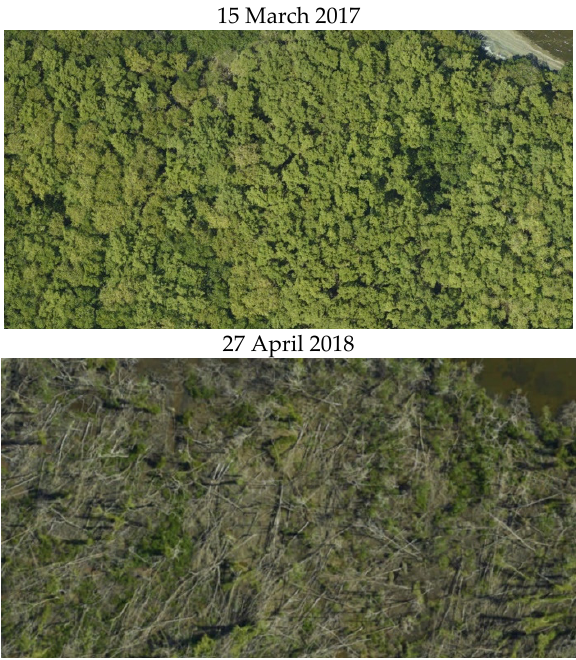
Figure A2. Aerial photographs taken before and after the hurricanes at the southern Piñones lagoon (–65.96 ◦ , 18.43 ◦ , source: NASA G-LiHT https://glihtdata.gsfc.nasa.gov/puertorico/, accessed on 24 August